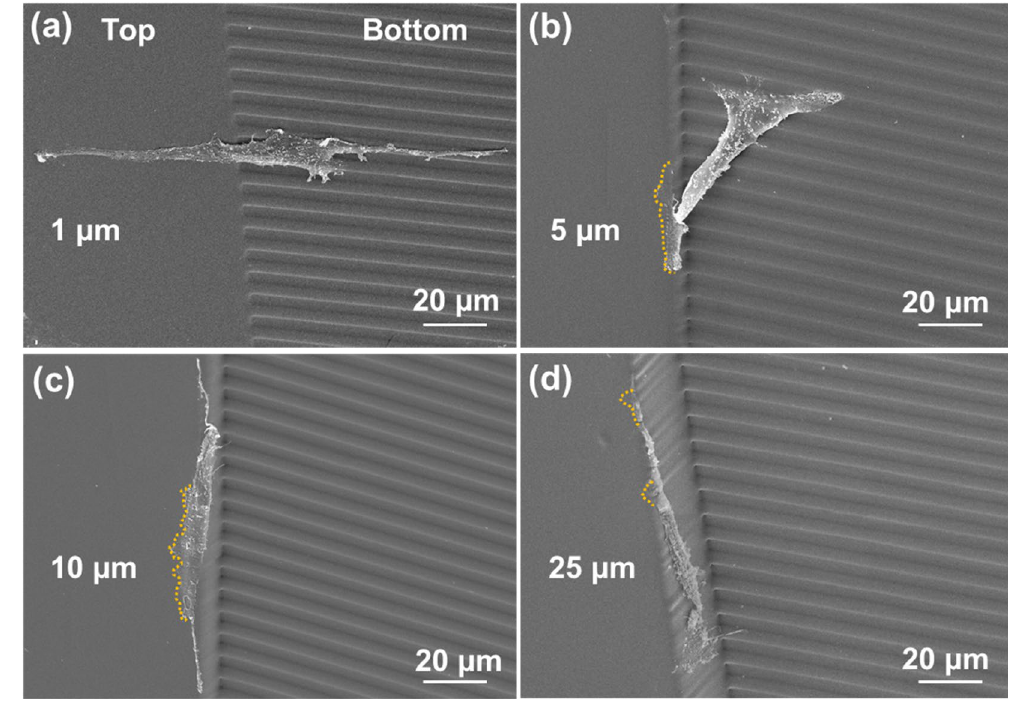
Figure 5. Micrographs of MC3T3 cells on grating pattern with ( a ) 1, ( b ) 5, ( c ) 10, and ( d ) 25 µm tall barriers. Yellow dash lines indicate lamellipodia on top of